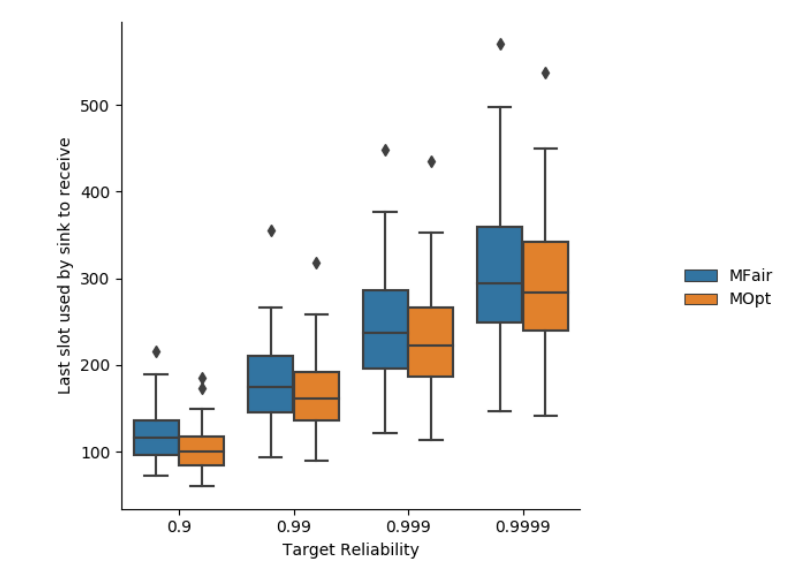
Figure 12. Maximum slot used by MFair and MOpt .